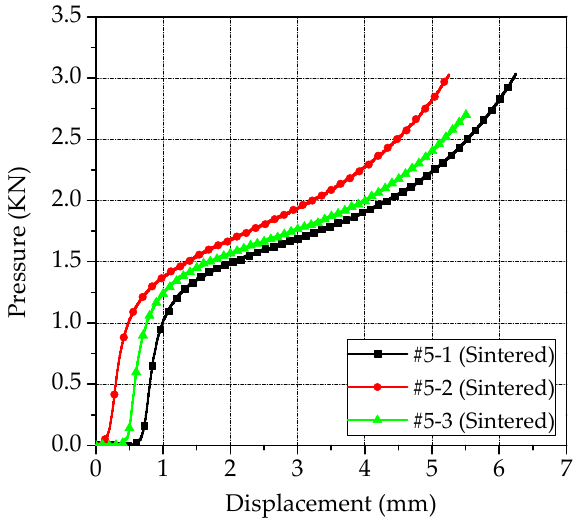
Figure 2. The pressure-displacement curves of the PTFE/Al/Si samples.